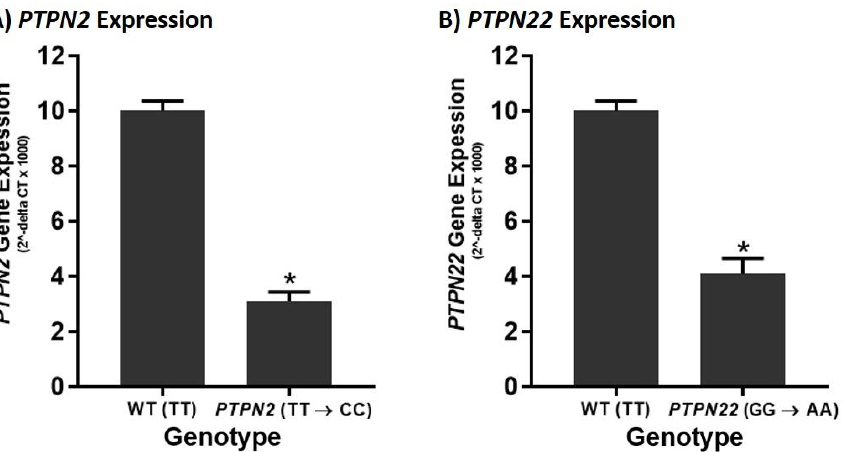
Figure 1. Effect of PTPN2/22 SNPs on Their Corresponding Gene Expression in CRISPR-Cas9-edited Jurkat T-cells. RT-PCR was used to measure expression of ( A ) PTPN2 and ( B ) PTPN22 in WT and CRISPR-Cas9-edited Jurkat T-cells ( PTPN2 SNP and PTPN22 SNP) (24 h) ( n = 3). * p < 0.05.